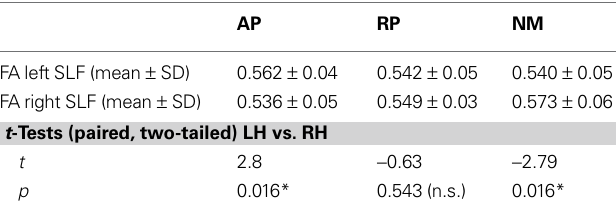
Table 2 | The upper part of this table contains the descriptive data (mean ± SD) refl ecting the performed ROI analysis based on thresholded probability maps. Additionally, the t-tests (*p < 0.05) show within-group differences (Bonferroni corrected) of the mean FA values between the left (LH) and the right hemisphere